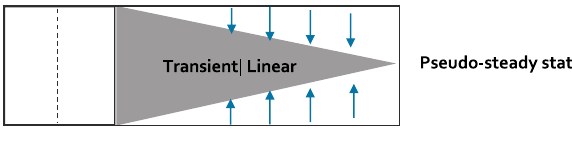
Fig. 3 Infinite fracture conductivity [ETR → LTR]